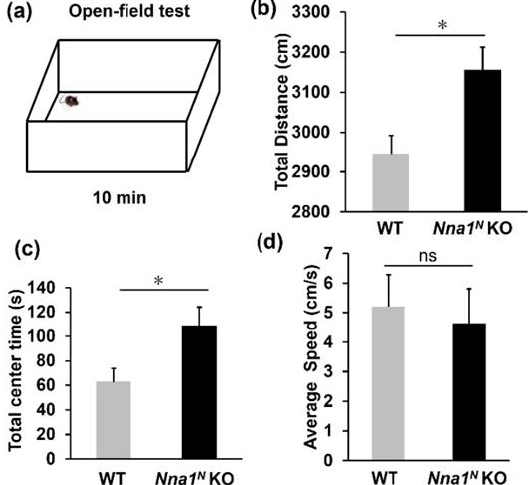
Figure 3. Anxiety-related behavior in Nna1 N KO mice observed by the open-field test. ( a ) Schematic representation of the open-field test. ( b ) Nna1 N KO mice traveled longer than the wild-type (WT) ones in the open-field test. ( c ) Nna1 N KO mice spent a longer time in the central region compared with the WT mice. ( d ) No significant difference was observed in the speed between KO and WT mice. WT, n = 6; Nna1 N KO, n = 10, * p < 0.05, Student’s t -test. All values presented are means ± SEM. “ns” means not significant.